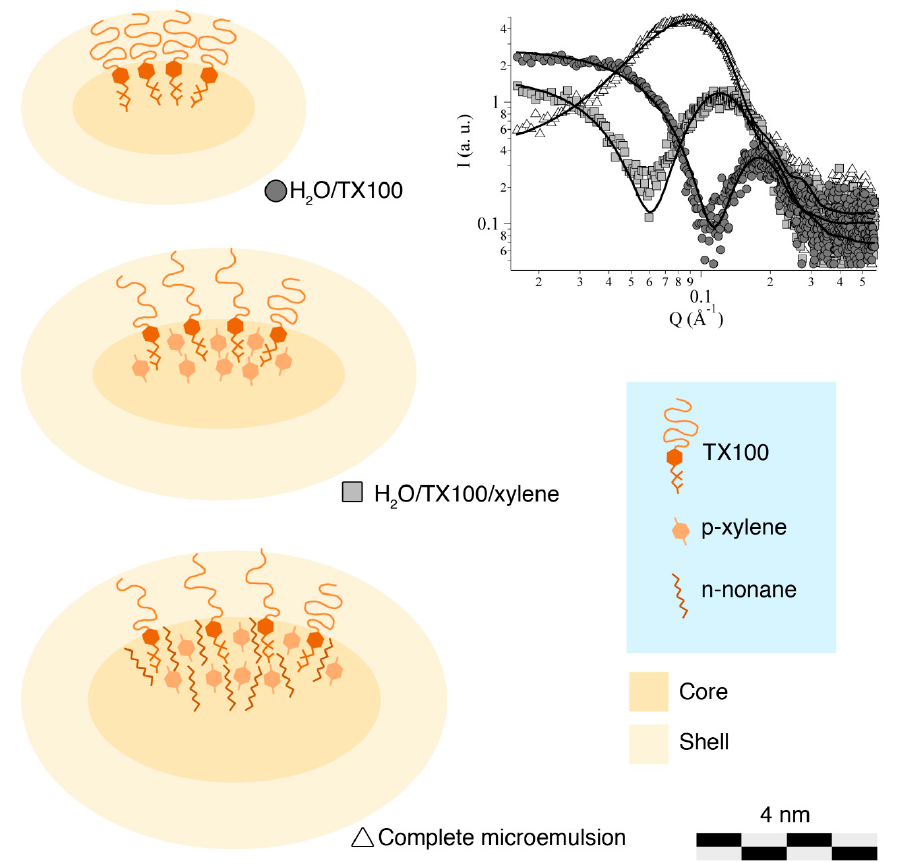
Figure 3. SAXS scattering profiles measured on three systems: H 2 O/TX100 (dark grey circles), H 2 O/TX100/xylene (light grey squares), complete microemulsion (white triangles). Fitting curves are reported as continuous black solid lines. The experimental errors are not reported here because they are smaller than the markers. The cartoon shows the evolution of the micelles (here reported as a vertical section) and the location of the components in the aggregates’ structure, as inferred by SAXS fitting results. Hydration water is not showed for sake of clarity. (Micelles reported here are about 8.7 million times larger than their actual size).